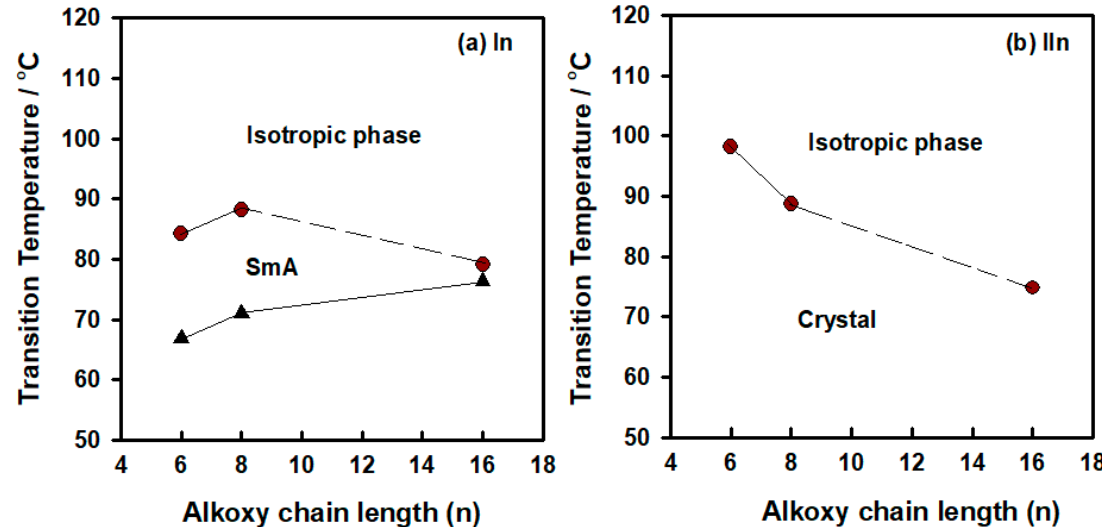
Figure 3. DSC transitions of synthesized groups ( a ) I n and ( b ) II n ; the smectic A mesophase for series I n was observed monotropically (upon cooling).